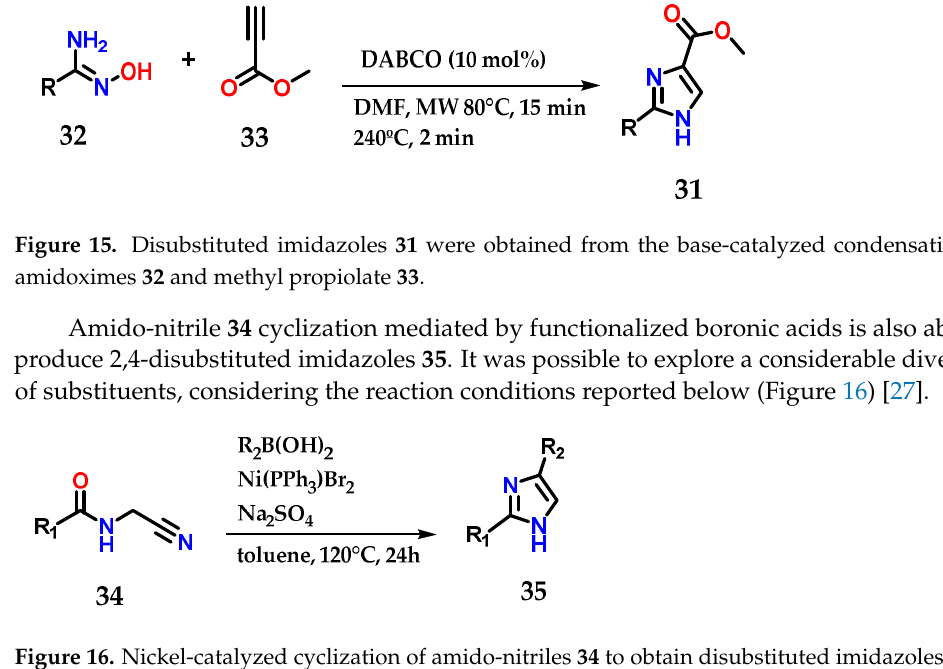
Figure 14. Synthesis of disubstituted imidazoles 27 starting from the acid-catalyzed oxidation of methylketones 28 .